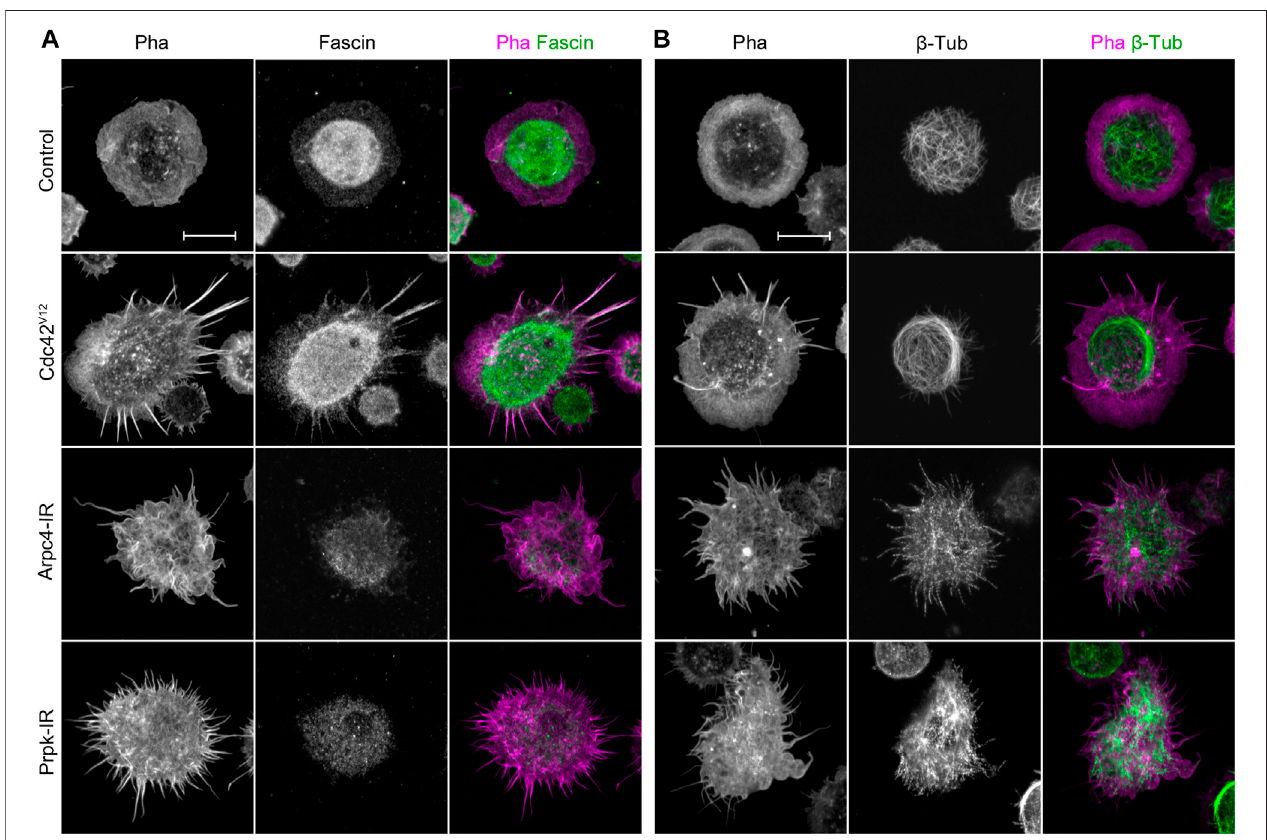
FIGURE 2 | Membrane protrusions in Prpk knockdown hemocytes are not canonical fi lopodia but are similar to protrusions observed in loss of lamellipodia condition. (A) Immunostaining of primary culture of hemocytes for F-actin with Phalloidin (Pha, red) and fi lopodia marker Fascin (green). (B) Immunostaining for F-actin (Pha, magenta) and β -Tubulin (green). Expressions: Control (Cg-Gal4 driver), Arp2/3 p20 subunit RNAi (Arpc4-IR), Prpk RNAi (Prpk-IR) and constitutively active Cdc42 (Cdc42 V12 ). Loss and gain of function conditions were induced in hemocytes using the Cg-Gal4 driver for each condition. Scale bars: 10 μ m.